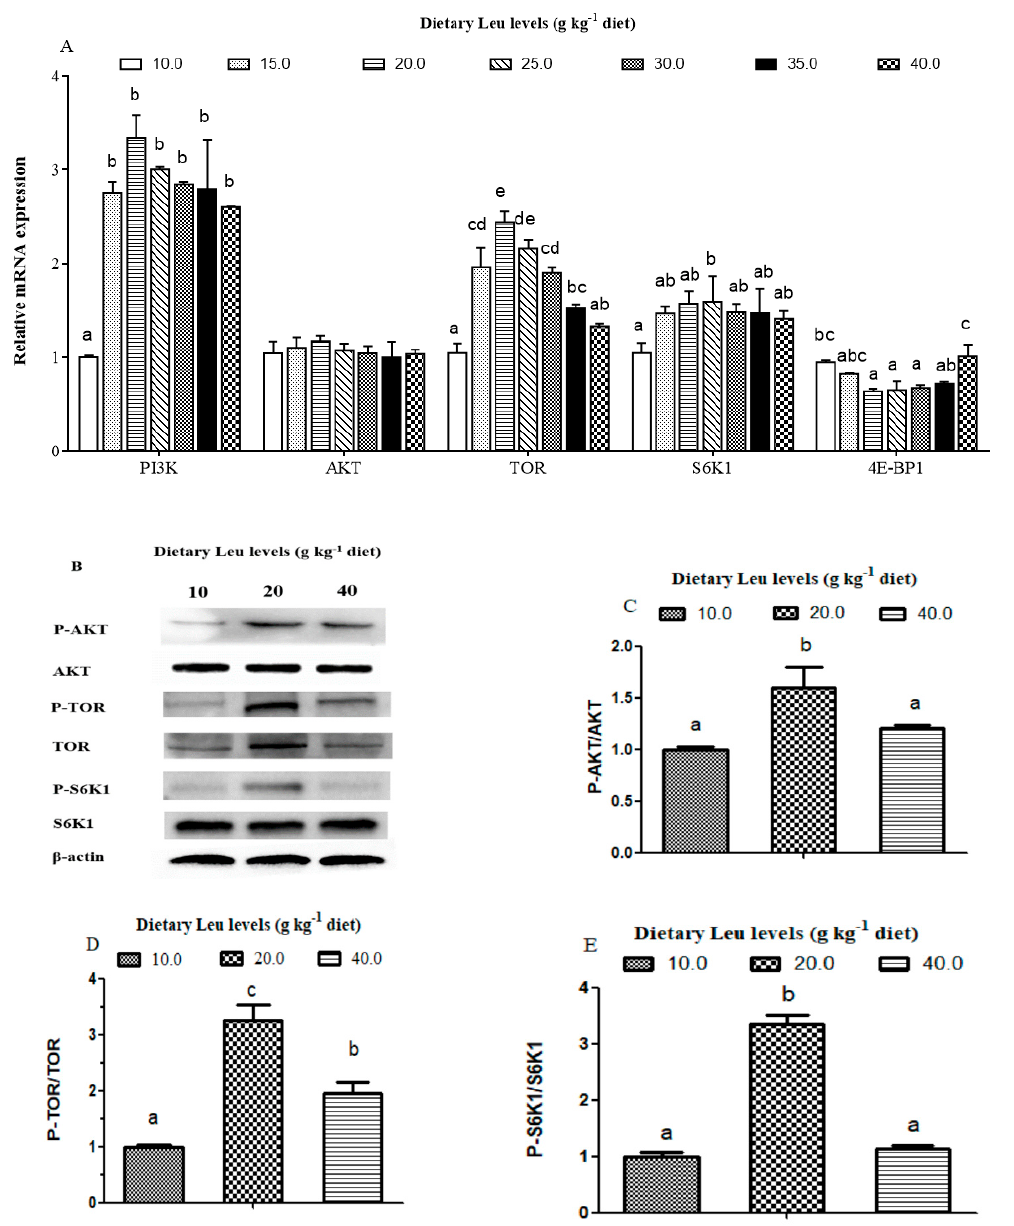
Fig ure 6. Effect of dietary Leu on the PI3K/AKT/TOR signaling pathway in hybrid catfish muscle. ( A ) Effect of dietary Leu on PI3K, AKT, TOR, S6K1, and 4E ‐ BP1 mRNA expressions in muscle of hybrid catfish. ( B ) Effect of dietary Leu on the protein expressions of P ‐ AKT (Ser473), AKT, P ‐ TOR (Ser2448), TOR, P ‐ S6K1 (Thr421/Ser424), and S6K1 in muscle of hybrid catfish. Results were expressed as the ratio of P ‐ AKT and AKT ( C ), P ‐ TOR and TOR ( D ), and P ‐ S6K1 and S6K1 ( E ) protein levels. Data represent means ± SEM of three replicates, with six fish in each replicate. Values having different letters are significantly different ( P < 0.05).